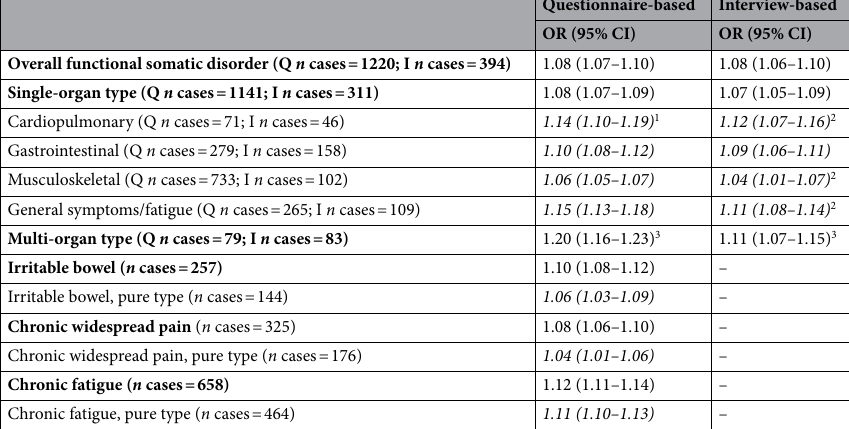
Table 1. Association between functional somatic disorders and neuroticism. Odds ratio of having functional somatic disorder comparing two individuals who differ one point on neuroticism. Adjusted for sex, age, social status, accumulated number of adverse life events, and self-efficacy. In all analyses, p < 0.05. Q questionnaires, I interview. 1 Only adjusted for sex, age, social status, and accumulated number of adverse life events. 2 Only adjusted for sex, age, and social status. 3 Only adjusted for sex and age. Significant values are in